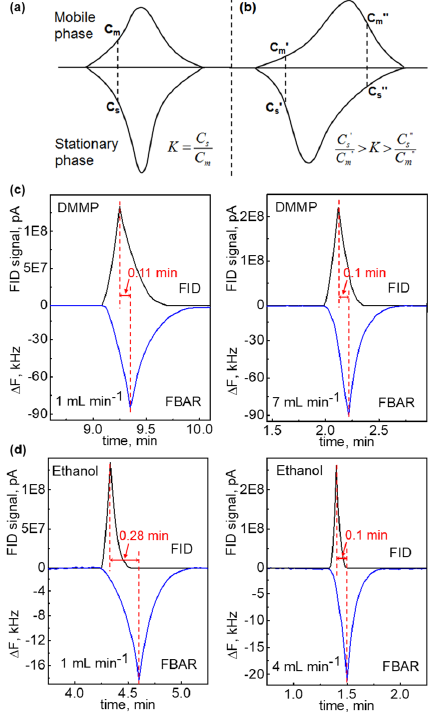
Figure 4. The measurement of the concentration profile on the solid surface by the PEI–coated mFBAR with the controlled concentration profile in the mobile phase by FID at the same time. ( a , b ) Simulated analyte concentration profile in the mobile gas phase (top) and in the stationary phase (bottom) for the fast mass transfer ( a ) and slow mass transfer ( b ). K is the equilibrium constant; C s , C (cid:48) s , C (cid:48)(cid:48) s , C m , C (cid:48) m and C (cid:48)(cid:48) m are the analyte concentration on the solid surface and in the mobile phase, respectively. ( c , d ) The comparison of chromatogram from FID (top) with that from the PEI–coated mFBAR (bottom) at the different flow rates for analyte DMMP ( c ) and ethanol ( d